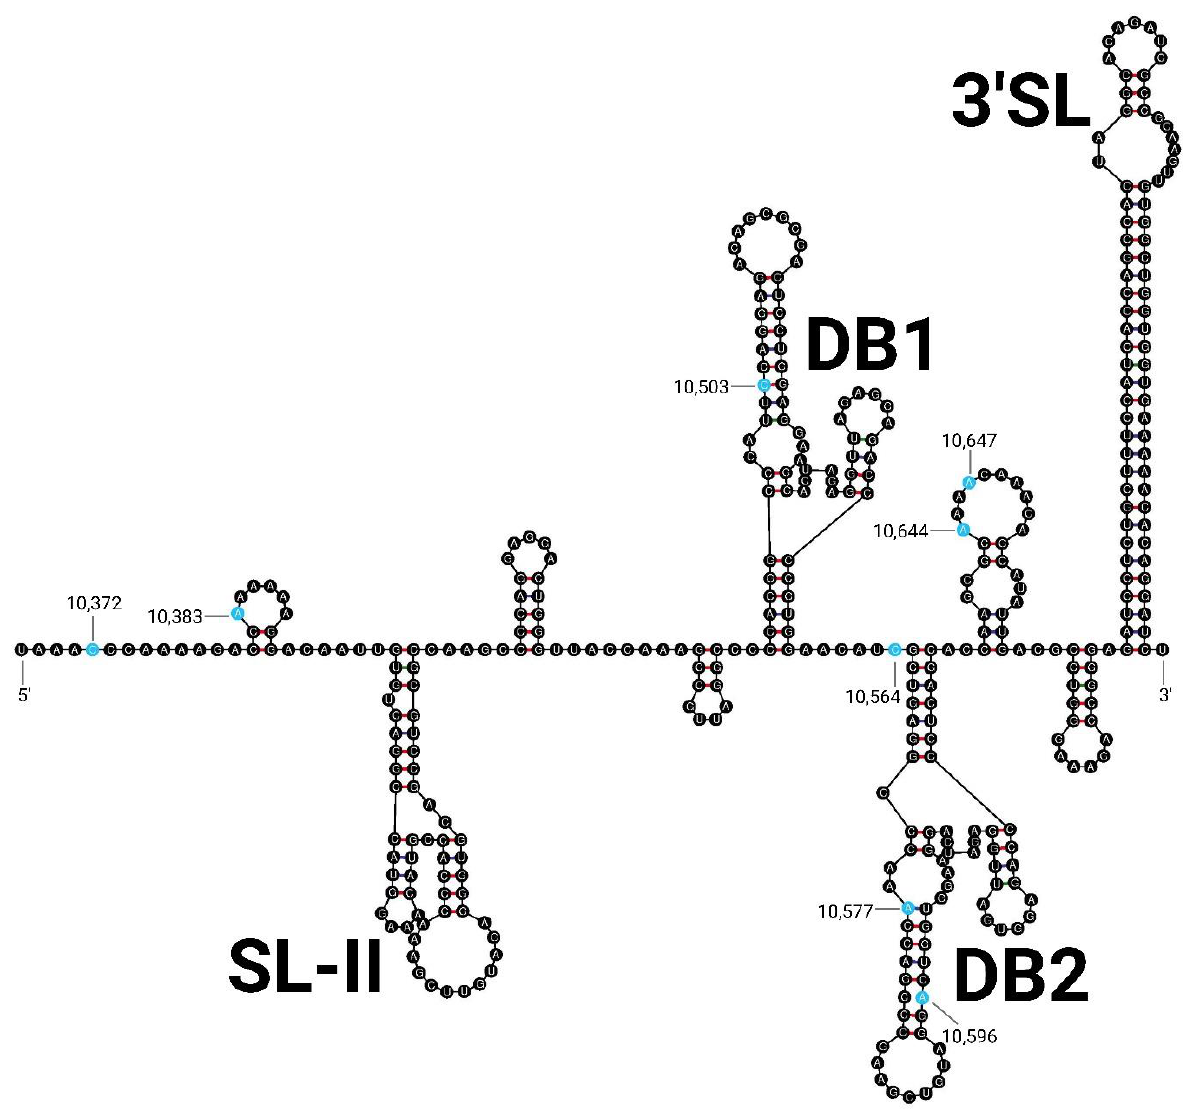
Figure 5. 3 (cid:48) UTR Structure of ILHV. Predicted structure of the consensus ILHV 3 (cid:48) UTR. The conserved flavivirus structural domains stem–loop II (SL-II), dumbbell 1 (DB1), dumbbell 2 (DB2), and 3 (cid:48) stem– loop (3 (cid:48) SL) are labeled. Variable sequence features are highlighted in blue, and their position in the ILHV Original sequence is